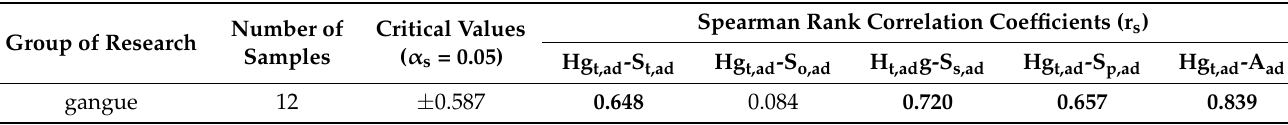
Table 7. Correlation coefficients (r s ) of Spearman rank correlation between Hg and other component in gangue samples. Group of Research